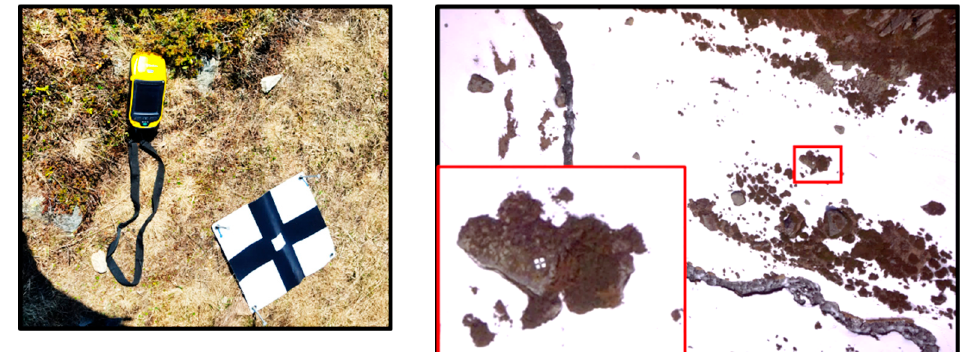
Figure 2. ( Left ) Trimble GeoExplorer 6000 GeoXH differential GNSS device and GCP; ( Right ) example depiction of GCP clearly visible in the UAS image.